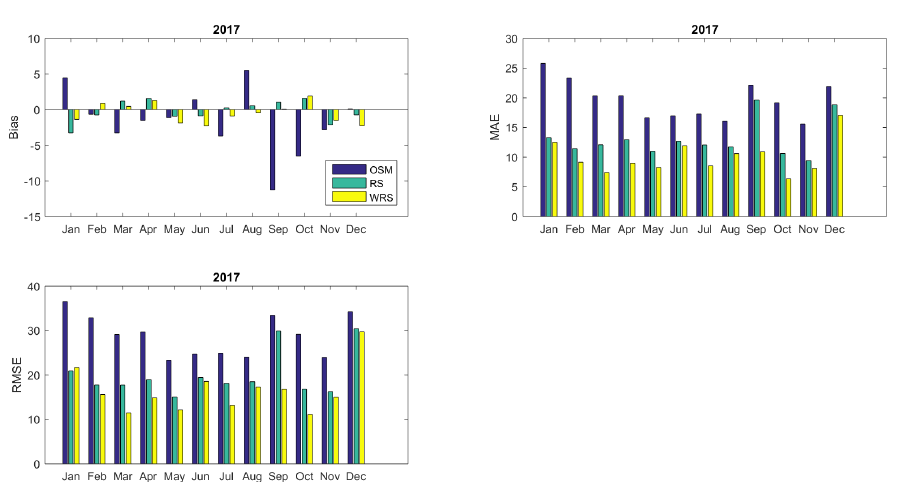
Figure 10. Statistical error indices for the Reshaped Simulation Model (RS) and the Weighted Reshaped Simulation Model (w-RS) for the year 2017 (per